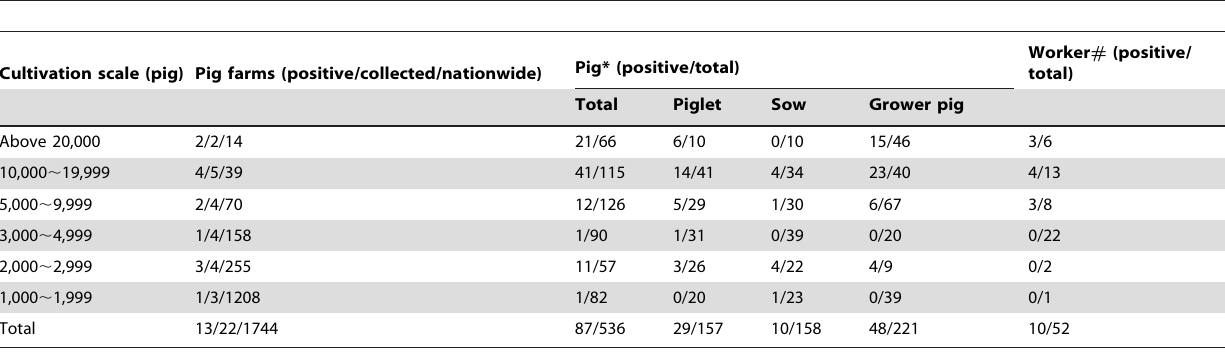
Table 2. Comparison of nasal methicillin-resistant Staphylococcus aureus carriage among 536 pigs and 52 related workers in 22 pig farms in Taiwan by different cultivation